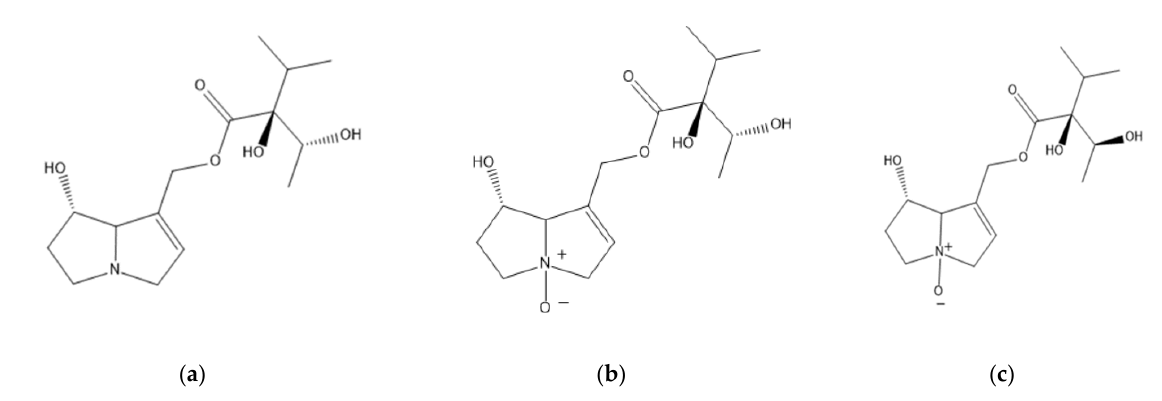
Figure 2. The structures of identified PA/PANOs: ( a ) echinatine, ( b ) echinatine N ‐ oxide, ( c ) rinderine N ‐